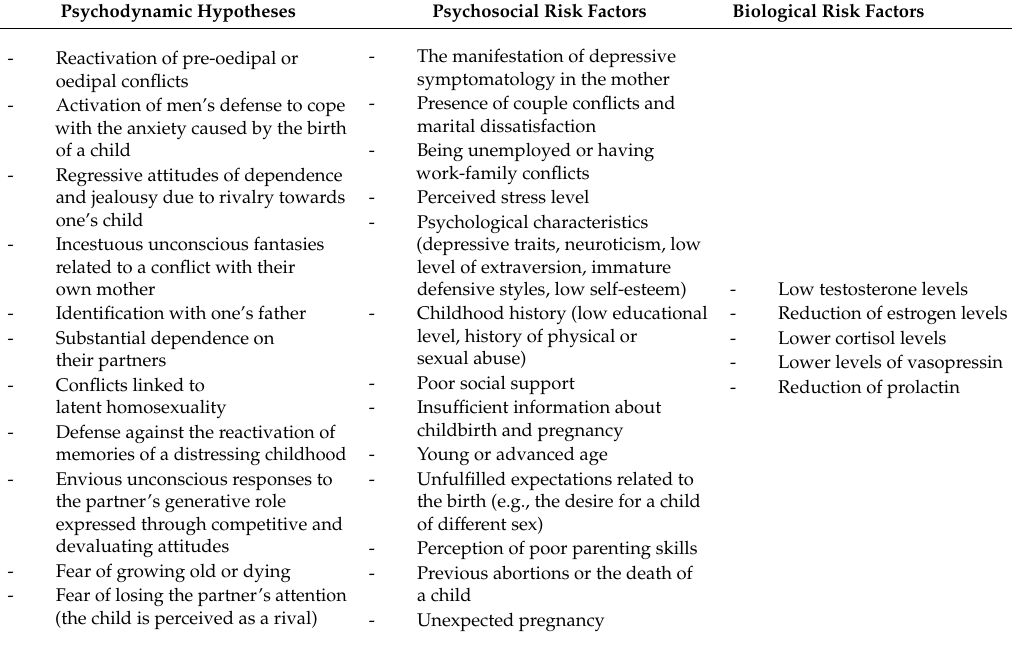
Table 1. Etiopathogenetic hypotheses and risk factors for paternal perinatal